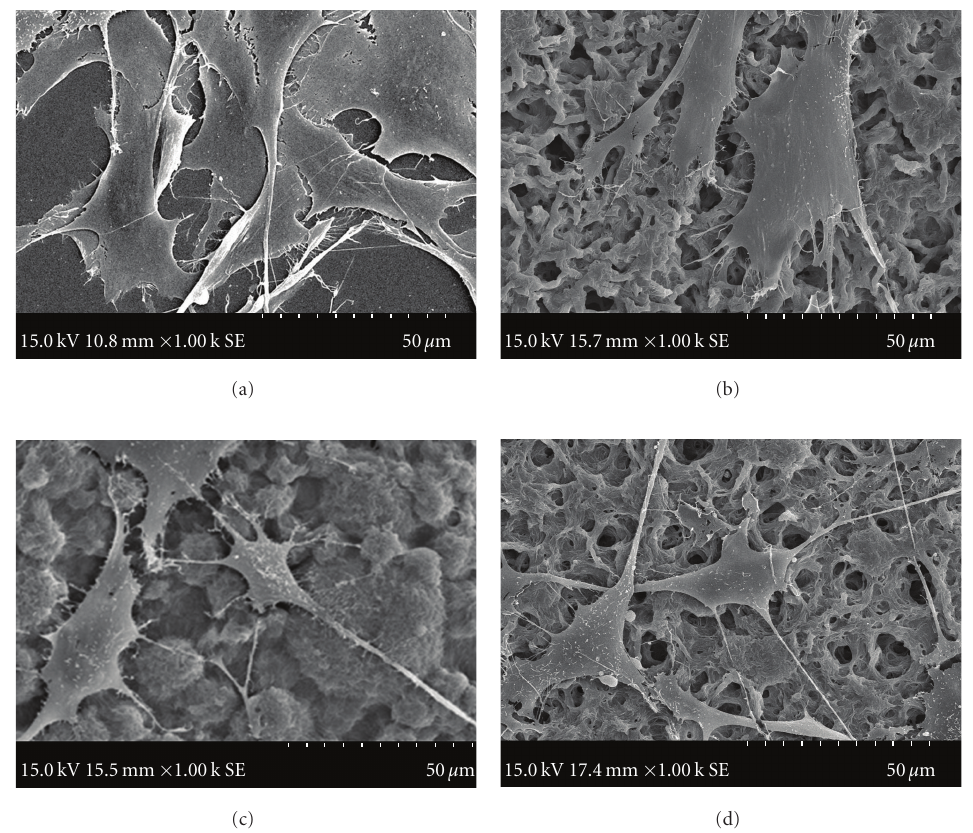
Figure 9: Scanning electron micrographs illustrating morphology of olfactory ensheathing cells attached to various surfaces after 24 hours of cultivation: (a) Polystyrene slide, (b) PHB film, (c) PHB/PEG106 with 20% w/w loading, and (d) PHB/PEG2000 with 20% w/w loading.